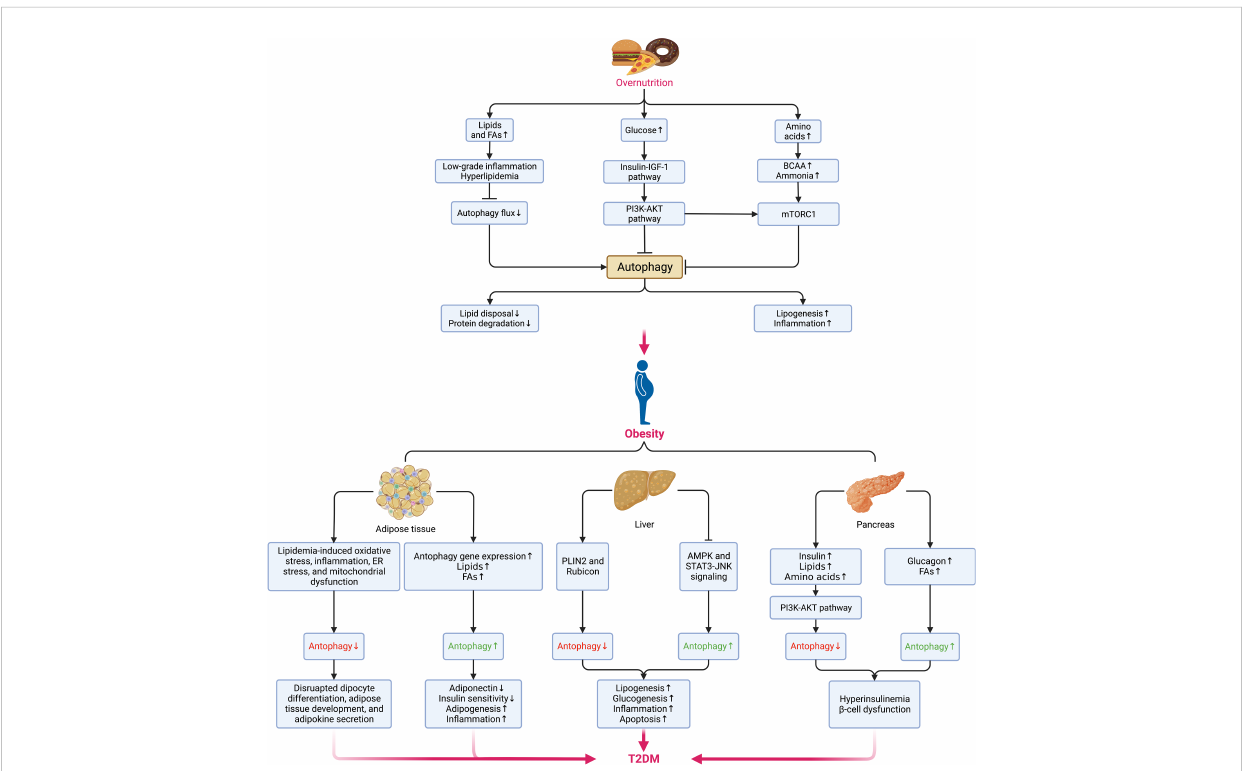
FIGURE 4 Alterations of autophagy in different metabolic organs during the transition from overnutrition and obesity to T2DM. The excessive intake of nutrients such as lipids, glucose, and amino acids results in the suppression of autophagy via different signaling pathways and contributes to obesogenesis by increasing the accumulation of lipids, and proteins, enhancing low-grade systemic in fl ammation and exacerbating insulin signaling. In obesity, distinct dissimilarities can be observed in the changes in autophagy among different sites. In adipose tissue, the elevations in the levels of lipids and FAs and the upregulation of autophagy genes can enhance autophagy, whereas cellular stress can suppress autophagy. While the hepatic can also be enhanced or blunted by different signaling pathways and lead to the promotion of lipogenesis, glucogenesis, in fl ammation, and apoptosis. Insulin and metabolites, such as lipids, amino acids, glucagon, and FAs can also induce a dual impact on pancreatic autophagy and result in hyperinsulinemia as an initial protective mechanism against hyperglycemia but eventually favors the onset of insulin resistance and DM following the concurrent dysfunction of b -cells. Pancreatic autophagy might also be enhanced by elevated levels of free fatty acids (FFAs) and glucagon in obesity. Jointly, all these disruptions in autophagy of different sites contribute to the aberrant accumulation of protein aggregates, lipids, and other detrimental components in the microenvironment that fuels cellular stress and causes insulin resistance and subsequent transition from obesity to DM. BCAAs, branched-chain amino acids; NAFLD, nonalcoholic fatty liver disease; NASH, nonalcoholic steatohepatitis. AKT, protein kinase B; AMPK, AMP-activated protein kinase; BCAA, branched-chain amino acid; DM, diabetes mellitus; ER, endoplasmic reticulum; FAs, fatty acids; IGF-1, insulin- like growth factor 1; JNK, Jun N-terminal kinase; mTORC1, mechanistic target of rapamycin (mTOR) complex 1; PI3K, phosphatidylinositol-3-kinase; PLIN2, perilipin 2; STAT3, signal transducer and activator of transcription